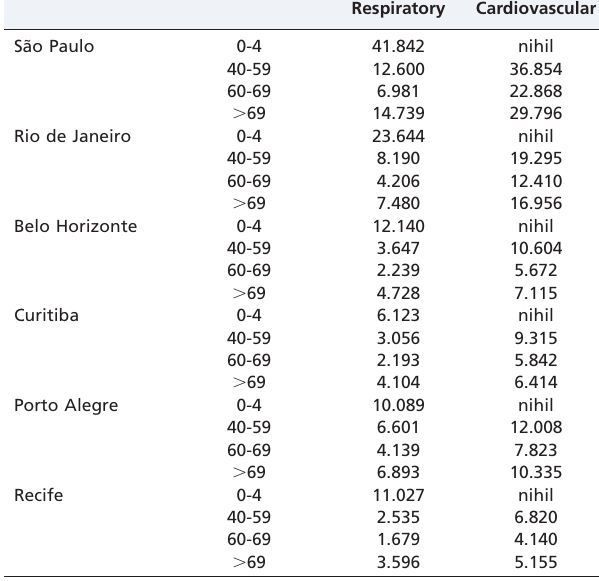
Table 2 - Total number of hospital admissions (2007) to the public health system attributable to respiratory and cardiovascular diseases according to age and metropolitan